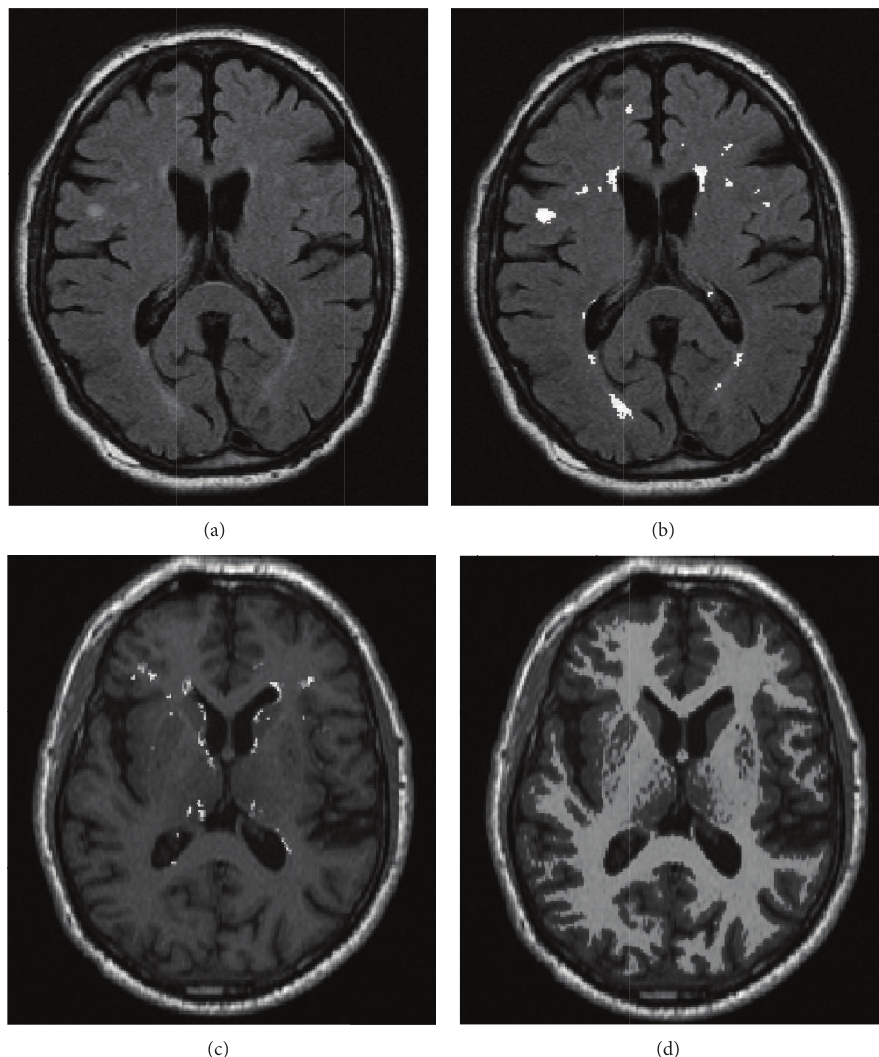
Figure 3: Overview of MR images and the ROIs used for feature extraction. (a) in the top left corner shows an example of an axial FLAIR MR image. The white matter lesions are possible to see as hyperintense areas. (b) in the top right shows the segmented voxels labelled as WML overlayed on the FLAIR MR image seen in (a). (c) in the bottom left corner shows the segmented WML voxels, found from the corresponding FLAIR, overlayed on the T1 MR image. (d) in the bottom right corner shows the segmented WM voxels overlayed on the T1 MR